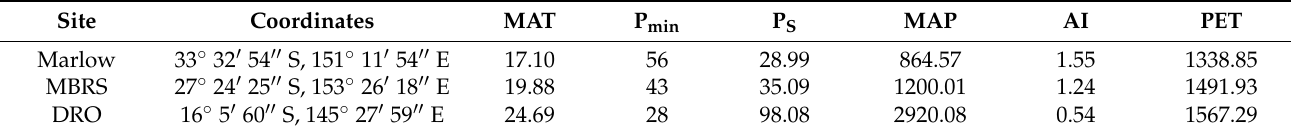
Table 1. Meteorological information of sample sites including mean annual temperature (MAT; ◦ C), minimum monthly precipitation of the year (P min ; mm), precipitation seasonality (P S ; coefficient of variation, unitless) (data were downloaded from WorldClim [46]), mean annual precipitation (MAP; mm), aridity index (AI; mm/mm), mean annual potential evapotranspiration (PET; mm) (data were downloaded from Ecosystem Modeling and Scaling Infrastructure